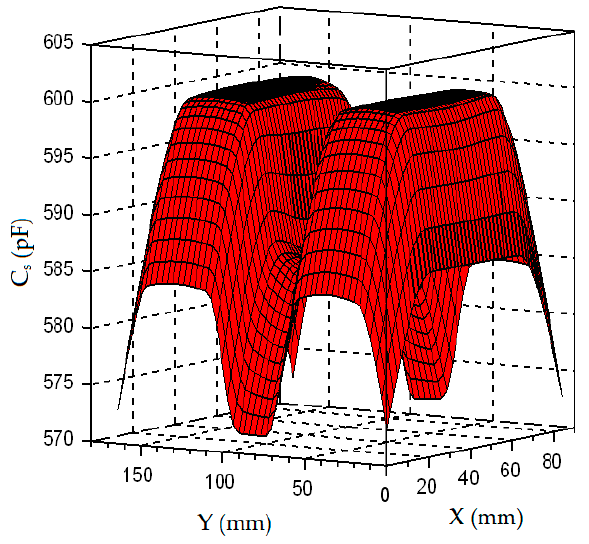
Figure 7. The 3D plot of the resultant parasitic capacitance C p as a function of the relative position.